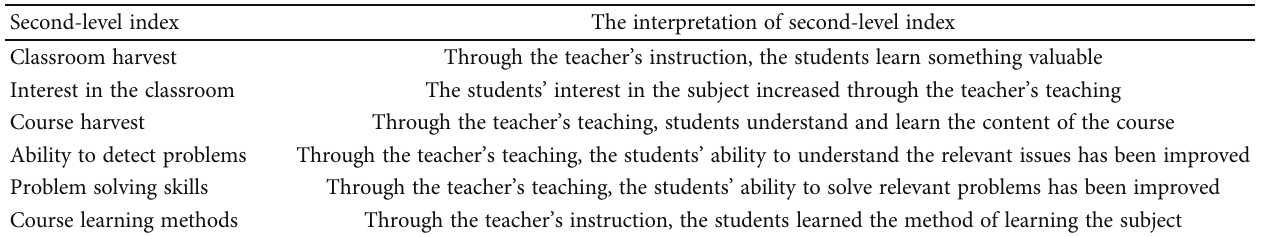
Table 10: Comprehensive evaluation index system of teaching reform projects ( fi rst-level index: students ’ listening e ff ect).